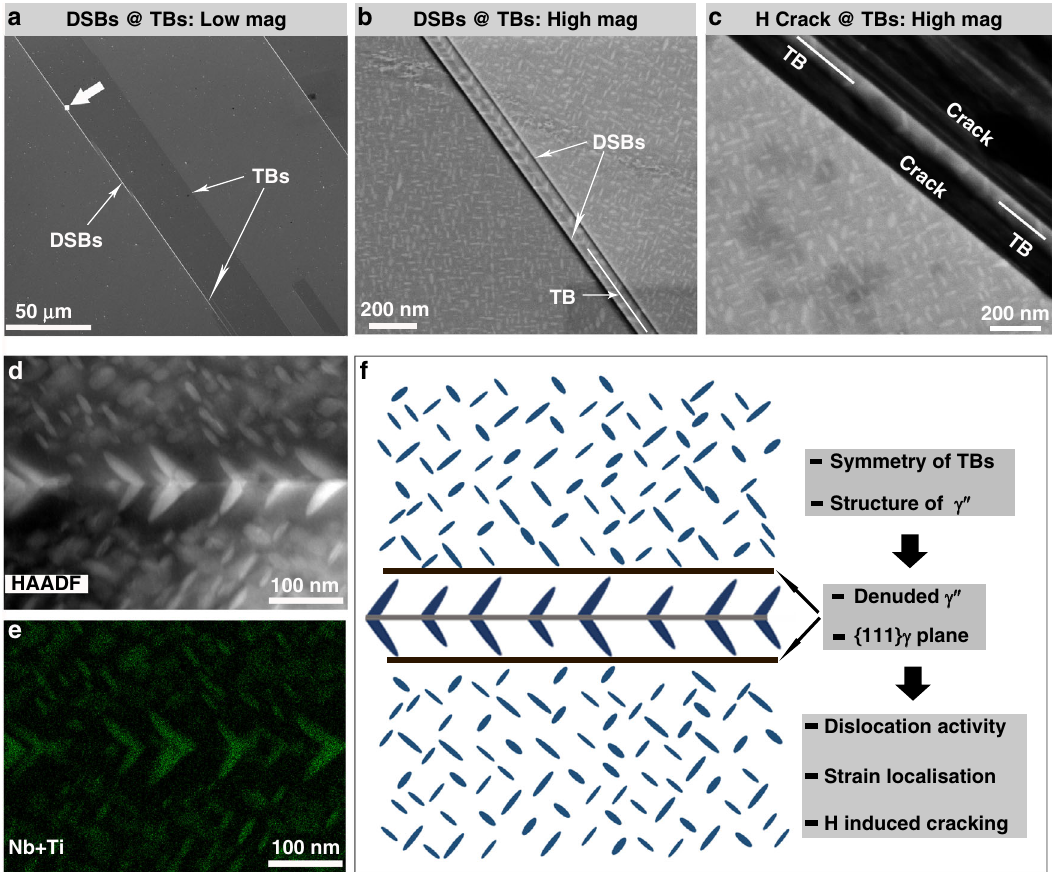
Fig. 6 Multiscale analyses illustrate the mechanistic origin of strain localisation and H-induced cracks associated with TBs. a A secondary electron image showing a region with several TBs and dislocation slip bands (DSBs) at TBs from the sample after slow strain rate test (SSRT) to a strain of 1%; b a BSE image taken at very high magni fi cation from the region masked by a white square in ( a ), where DSBs can be seen at the two sides of TB; c a BSE image taken at very high magni fi cation from the H-charged sample after SSRT to failure showing two parallel cracks on both sides of the TB; d , e HAADF STEM image containing a TB and its corresponding EDX Ti + Nb elemental map; f a schematic diagram showing the con fi guration of γ ″ around a TB, and coarser and V-shaped γ ″ along a TB leads to formation of ‘ weak ’ planes with denuded γ ″ , which serve as easy channels for dislocation